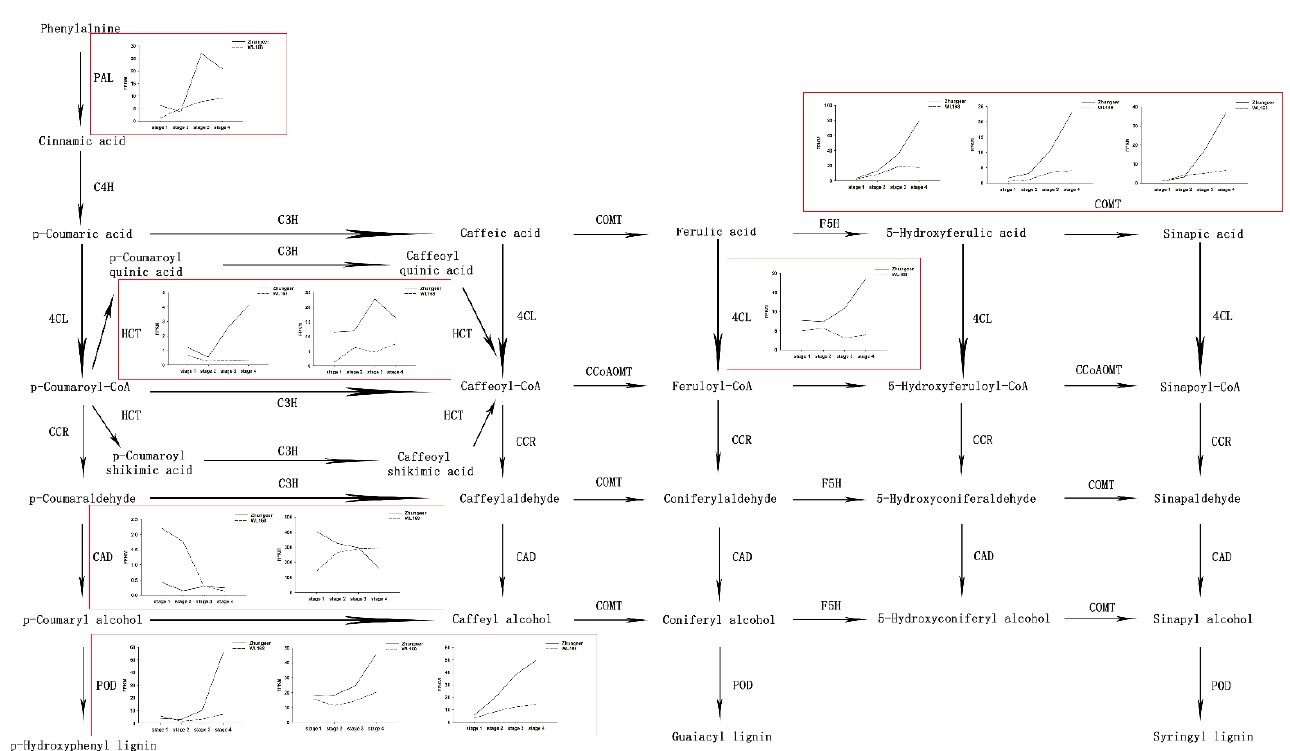
Figure 6. Lignin biosynthetic pathways. FPKM, fragments per kilobase of exon model per million mapped fragments. The real line represents Zhungeer and the imaginary line represents WL168.